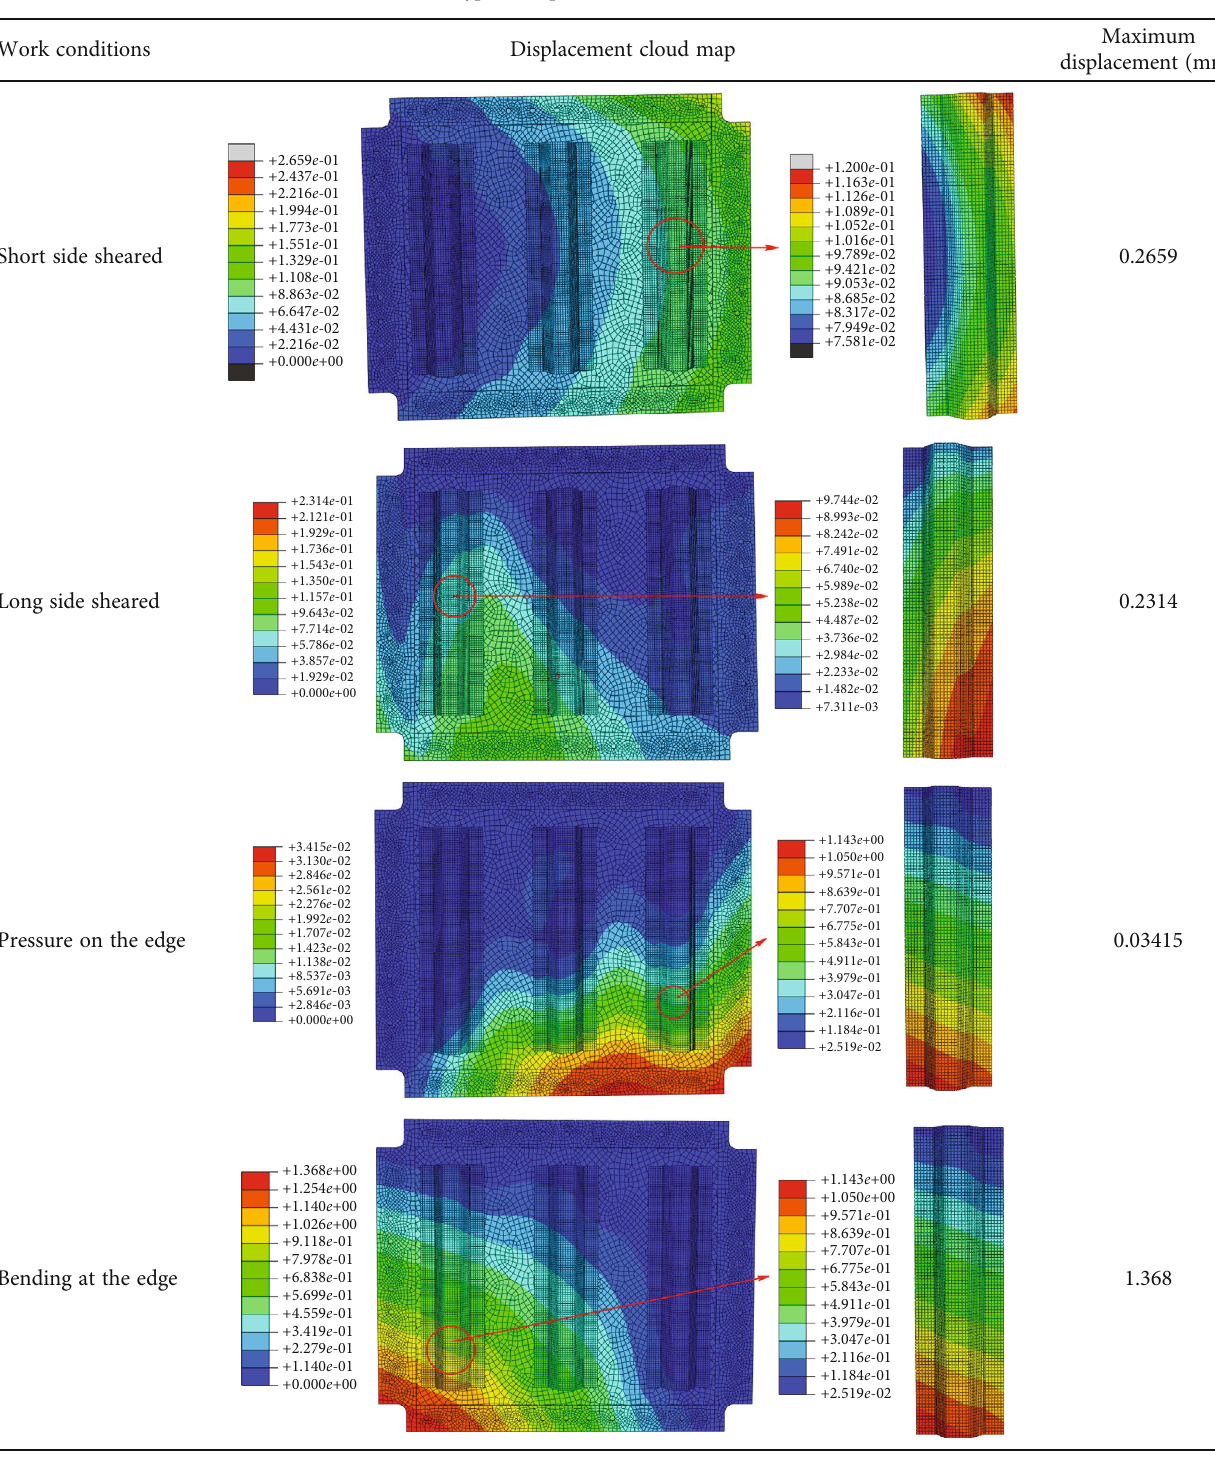
Table 7: Typical displacement clouds under static